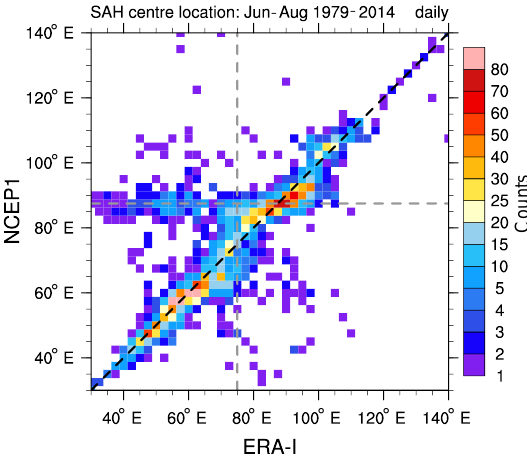
Figure 3. Scatter plot of the daily longitudinal location of the SAH centre during June–August 1979–2014 at 100hPa as diagnosed by ERA-I and NCEP-1 (note the non-linear colour scale). Dashed black line indicates the perfect one-to-one correspondence and grey lines indicate strong deviations from the perfect